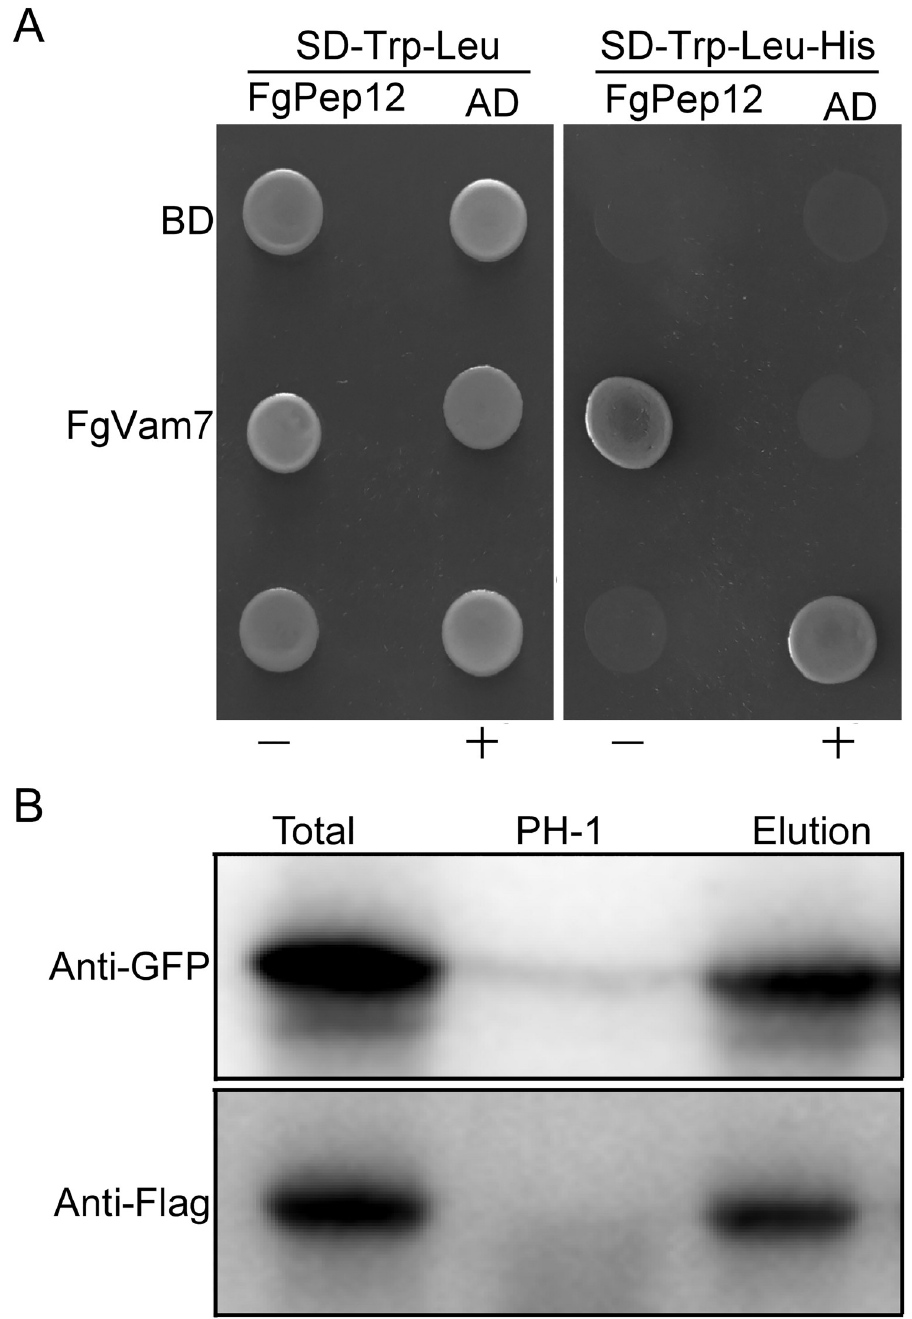
Fig 1. FgPep12 physically interacts with FgVam7. (A) Yeast two-hybrid assays for the interaction between FgPep12 and FgVam7. The prey and bait constructs were assayed for growth on SD-Leu-Trp and SD-Leu-Trp-His plates. +, positive control; -, negative control. (B) Co-immunoprecipitation assays for the interaction between FgPep12 and FgVam7. Total proteins were isolated from transformants co-expressing GFP-FgPep12 and FgVam7-3 × FLAG constructs, and proteins eluted from the anti-FLAG M2 beads (elution). Immunoblots were incubated with monoclonal anti-FLAG and anti-GFP antibody, respectively.